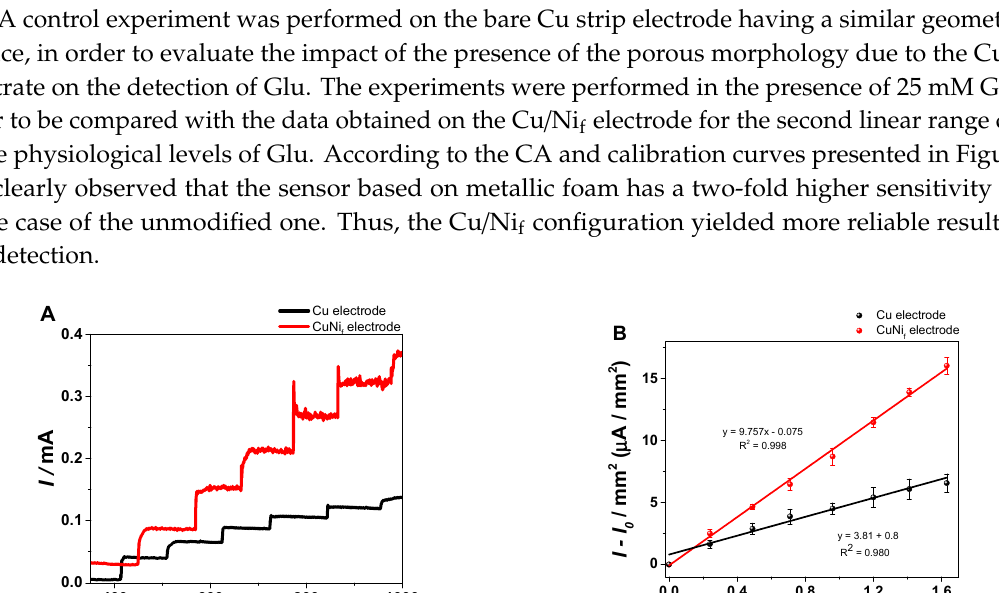
Figure 9. CV in 0.1 M NaOH solution in the presence of 150 µM UA ( A ) and 150 µM P ( B ) as interfering agents in the absence (black line)/presence (red line) of 150 µM Glu. (0–0.8 V, scan rate 25mV/s, working electrode surface area of 25 mm 2 ). It can be clearly seen that on the Cu/Ni f configuration the presence of both UA and P did not interfere with the anodic signal corresponding to the electrochemical oxidation of Glu. The current responses of Glu, UA, P, AA and R were also investigated at a constant potential of +0.55 V vs. Ag/AgCl, applying the same protocol as previously detailed, and the results are presented in Figure 10.